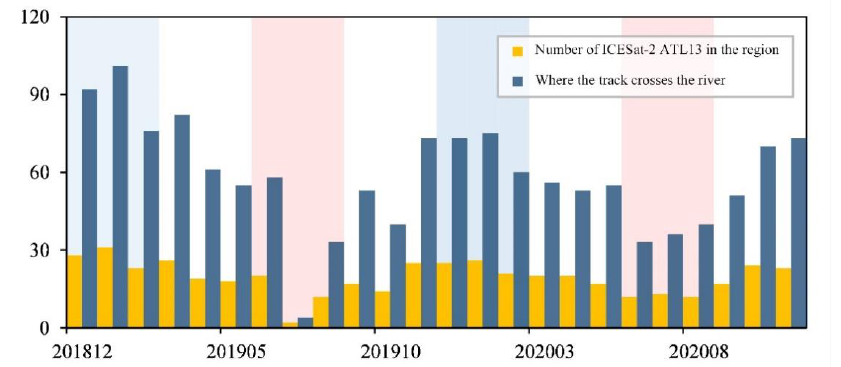
Figure 5. Number of ICESat-2 data-producing river passages by month.